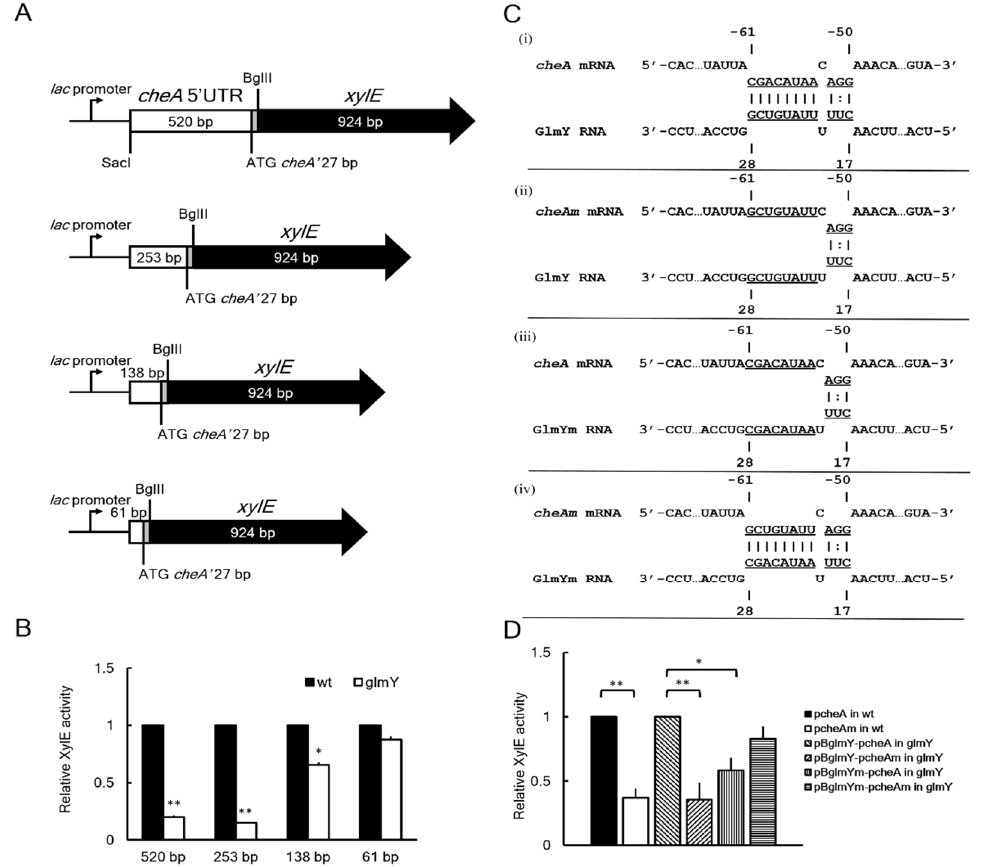
Figure 4. GlmY activated cheA expression at the post-transcriptional level. ( A ) Schematic representation of the different constructs used in the cheA-xylE translational reporter assay. The various lengths of cheA 5 ′ UTR (520, 253, 138 and 61 bp before AUG plus 27 bp after AUG were in frame ligated to xylE gene to obtain the translational fusion under the control of lac promoter in the pGEM-T easy vector. ( B ) The effect of various lengths of cheA 5 ′ UTR (as shown in ( A )) on XylE activity of the cheA 5 ′ UTR- xylE translational fusion in the wild-type and glmY mutant. The activity of XylE in the translational cheA 5 ′ UTR- xylE reporter plasmid-transformed P. mirabilis strains was determined using the reporter assay at 5 h after incubation on an LB agar plate. The value obtained for the wild-type strain at a length of 5 ′ UTR was set at 1. The data are the averages and standard deviations of three independent experiments. Significant difference from the wild-type is indicated (* p < 0.05; ** p < 0.01 by the Student’s t test). ( C ) The predicted region of base-pairing between GlmY and the 5 ′ UTR of the cheA mRNA. The interaction site of cheA and GlmY are underlined and the substitutions present in GlmY (GlmYm) and cheA 5 ′ UTR ( cheA m) are shown. ( i ). Wild-type GlmY and cheA 5 ′ UTR; ( ii ) wild-type GlmY and mutated cheA 5 ′ UTR; ( iii ) wild-type cheA 5 ′ UTR and mutated GlmY; ( iv ) mutated GlmY and the compensatory mutations in cheA 5 ′ UTR. ( D ) Analysis of GlmY interaction with cheA 5 ′ UTR for cheA expression. The cheA 5 ′ UTR (253 bp)- xylE translational fusion plasmid (pcheA) and glmY -containing pBAD33 (pBglmY) were used as templates for introducing an 8-bp substitution (shown in ( C )) into GlmY and cheA 5 ′ UTR by site-directed mutagenesis to produce pcheAm and pBglmYm, respectively. The pcheA and pcheAm were introduced into wild-type P. mirabilis separately , while glmY mutant was transformed with combinations of pBglmY-pcheA, pBglmY-pcheAm, pBglmYm-pcheA or pBglmYm-pcheAm. Then, the activities of XylE in the various glmY mutants (in the presence of 0.2% arabinose) and wild-types were determined at 5 h after incubation on an LB agar plate. The relative XylE activity was shown with the value of the pcheA-harbored wild-type or glmY mutant carrying pBglmY and pcheA set at 1, respectively. Significant difference from the wild-type or glmY mutant set at 1 is indicated (* p < 0.05; ** p < 0.01 by the Student’s t test). wt, wild-type; glmY, glmY mutant.